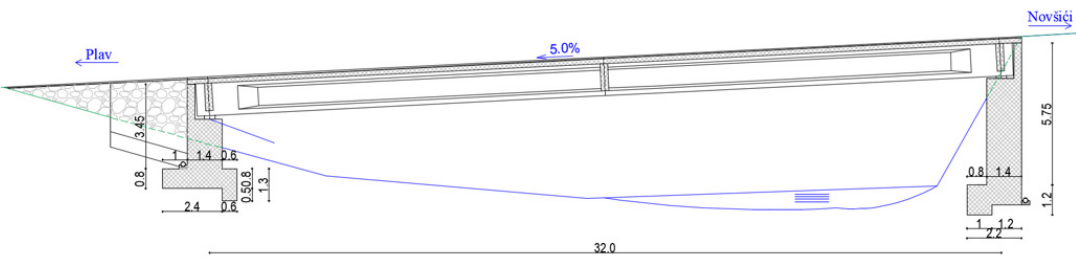
Figure 26. Longitudinal section of the designed bridge